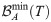
Minimal budgets for different activist fractions.We set k = 10 and used the following initial conditions: a0(0) = b0(0) = (1 − a+ − b+ − o)/2 with o(0) = 0.2. The convincing probabilities are fixed to ρA = ρB = 1 and the costs to cA = cB = 2. In the left panel, the minimal budgets BAmin(T) and BBmin(T) according to Eqs (4) and (5) are displayed as a function of the fraction a+ for different values of b+. The black solid line indicates a given budget B=4.5 for campaign of duration T = 15 and the orange areas represent the corresponding regimes of possible choices for a+ for which the given budget B suffices. The right panel shows a three-dimensional illustration of the budget BA as a function of a+ and b+. The plane again represents a given budget B=4.5. All values of a+ and b+ leading to budget values below or on the plane are possible choices to have a sufficient budget.